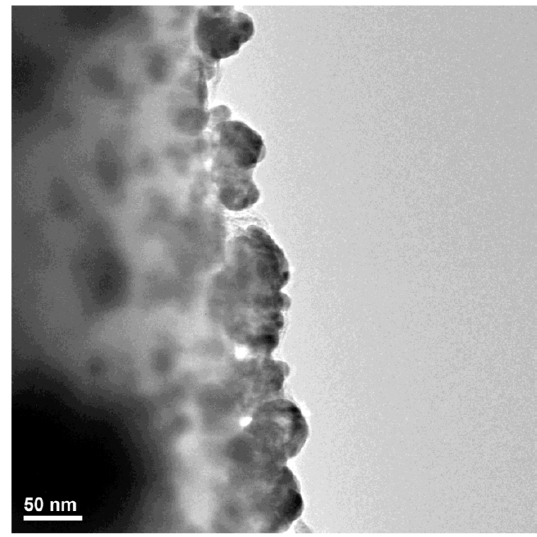
Figure 3. TEM bright field image of NanoAg-WDs.